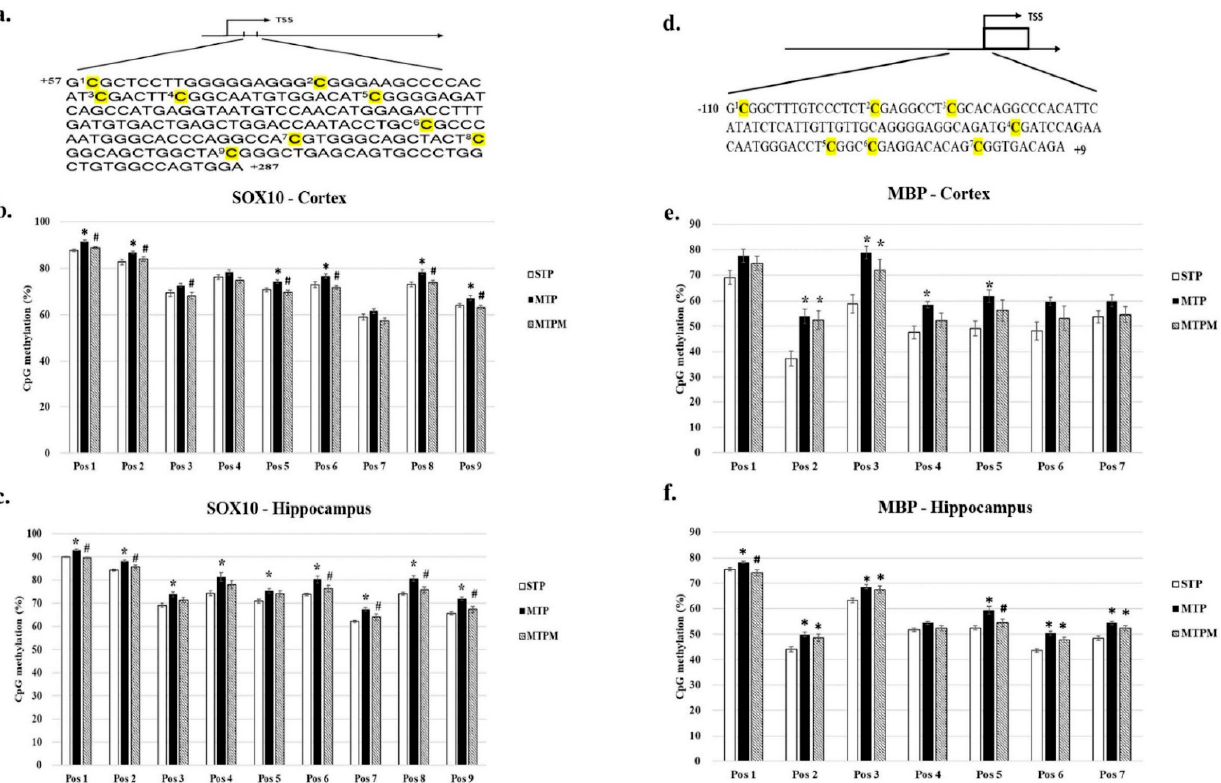
Figure 3. MTX treatment stimulated the alteration of CpG methylation status in myelination-related genes promoter, while melatonin attenuated the alteration resulted from MTX. ( a ) Scheme of SOX10 promoter region for pyrosequencing. CpG positions are highlighted in yellow background. ( b ) Methylation status in different CpG sites of SOX10 promoter in brain cortex. ( c ) Methylation status in different CpG sites of SOX10 promoter in hippocampus. ( d ) Scheme of MBP promoter region for pyrosequencing. CpG positions are highlighted in yellow background. ( e ) Methylation status in different CpG sites of MBP promoter in brain cortex. ( f ) Methylation status in different CpG sites of MBP promoter in hippocampus. “C” highlights in bold with yellow background indicate variable CpG positions. (*: p < 0.05 vs. STP; #: p < 0.05 vs. MTP).